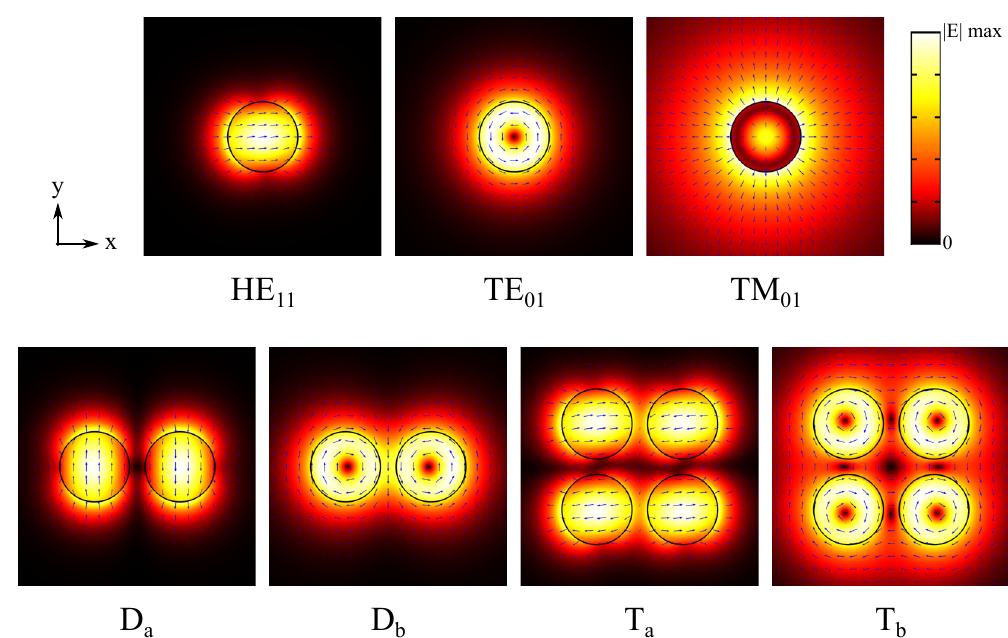
Figure 3. Electric field plots in the xy -cross-section of the uncoated nanowire oligomer waveguide modes included in the analysis. The color map shows the field norm the transverse field direction. Here, the nanowire diameter is 450 nm and nanowire separation is 100 nm.